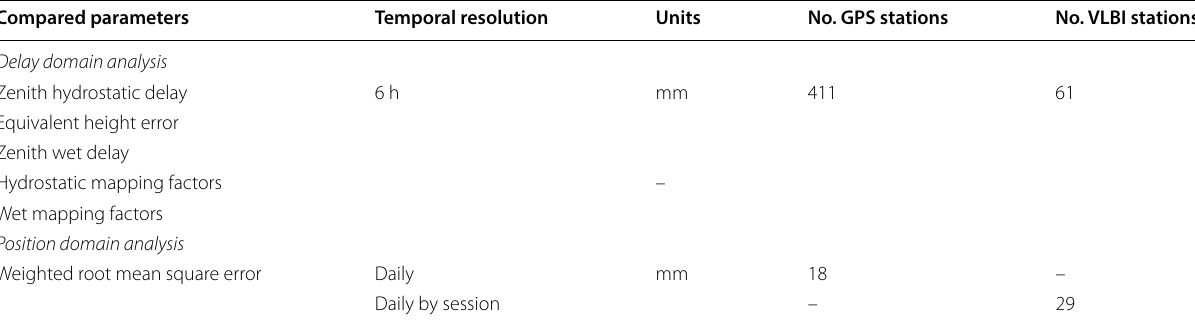
Table 2 Summary of the parameters compared in the analyses and their characteristics Compared